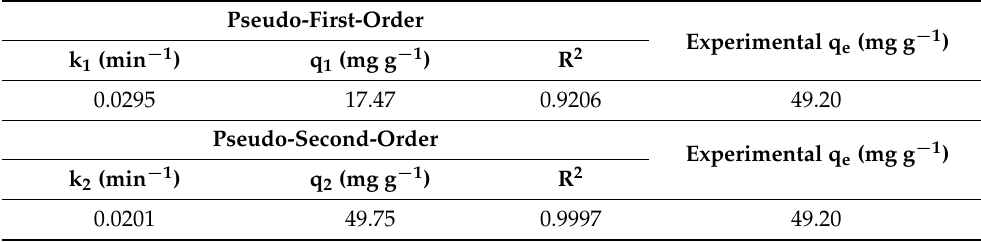
Figure 7. Linearized data of the pseudo-first-order kinetic model and the pseudo-second-order kinetic model. The solid line in this figure is the connecting line of the measured value, and the dotted line is the fitting straight line. ( a ) The pseudo-first-order kinetic model; ( b ) The pseudo-second-order kinetic model. Table 3. Coefficients of determination of the linearized pseudo-first and pseudo-second-order models and the respective modeled and experimental